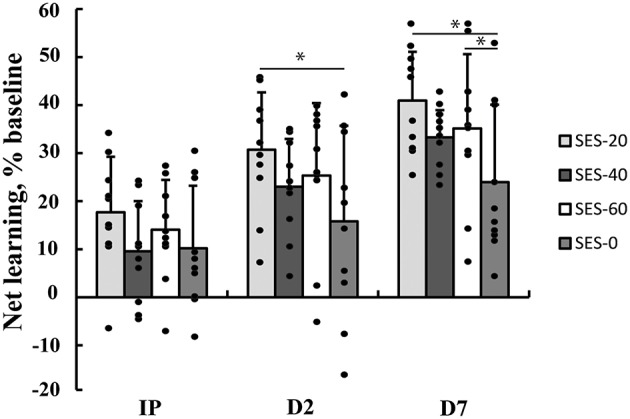
Increases in visuomotor performance after 0, 20, 40, or 60 min of somatosensory electrical stimulation (SES). Percent increases are corrected for improvements as a result of familiarization with the task immediately post (IP), on Day 2 (D2), and Day 7 (D7). Performance increased more in SES-20 compared to SES-0 on Day 2. On Day 7, performance increased more in SES-20 and SES-60 compared to SES-0. *Group by Time interaction with SES-0 (p < 0.05). Black dots represent individual changes. Vertical bars denote +1 SD.